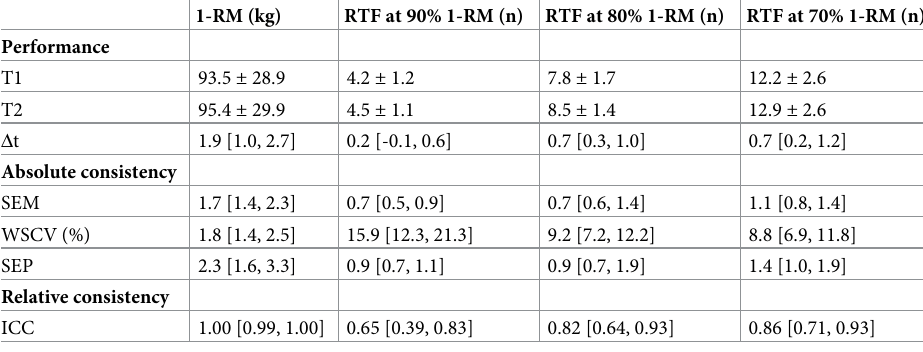
Table 1. Consistency statistics for strength performance in the bench press.